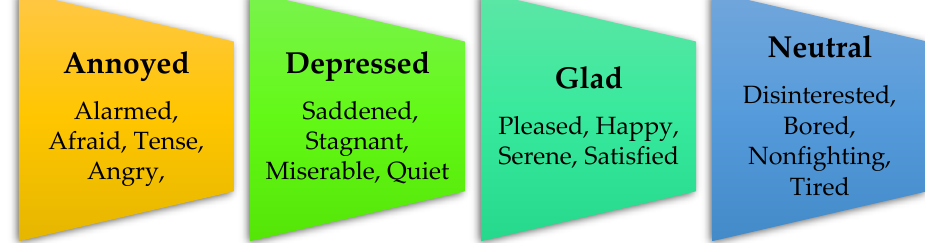
Figure 1. Different Emotional States Adapted from Circumplex Model.